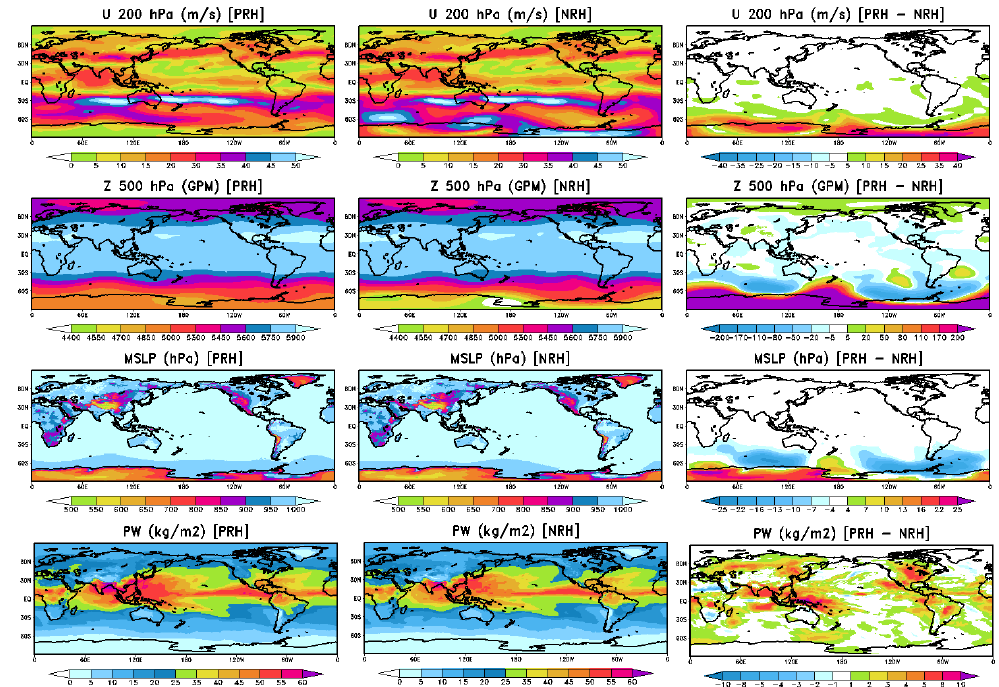
Figure 1. Mean fields of the initial conditions of zonal wind at 200 hPa (U200 hPa), 500 hPa geopotential height (Z500 hPa), mean sea level pressure (MSLP), and water precipitable (PW) compared with experiments that utilized pseudo-RH (PRH) and normalized RH (NRH) in